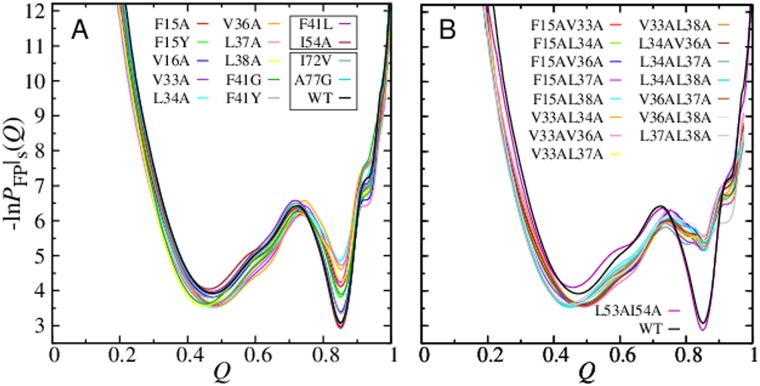
Kinetic effects of mutations in the db+MJhϕ model for Im7.Kinetic FP profiles of single (A) and double (B) mutants under strongly folding conditions corresponding to zero denaturant in experiment. The reference WT profile is also shown. The depth of the kinetic trap at Q ≈ 0.85 for the single mutants in (A) increases in the following order: L34A (shallowest) < L37A < V36A < L38A < V33A < F15A < F41G < F15Y < V16A < F41Y < I72V < A77G < WT < F41L < I54A (deepest). The boxes in (A) enclose mutations that lead to very similar kinetic FP profiles. The kinetic FP profiles for the double mutant L53AI54A and the WT in (B) are also very similar.